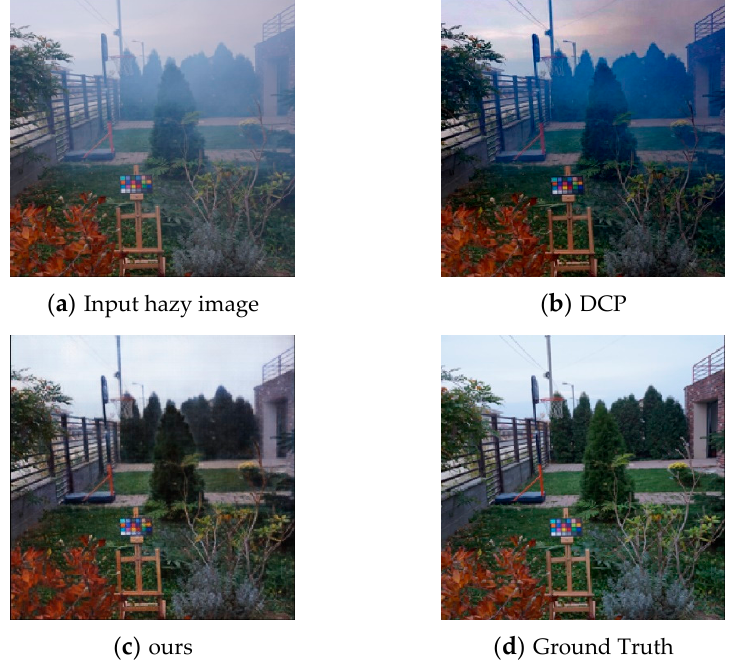
Figure 1. Image dehazing examples with and without prior information. ( a ) Input hazy image; ( b ) dark channel prior (DCP); ( c ) ours; ( d ) ground